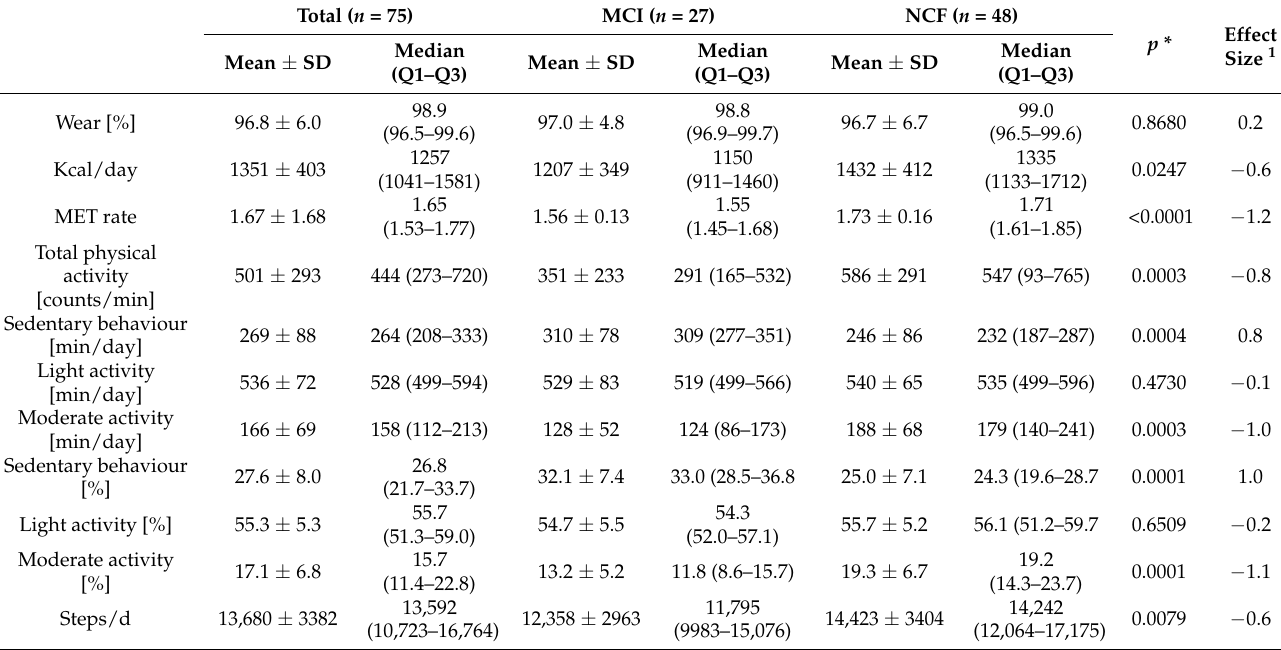
Table 4. Physical activity results assessed by the ActiGraph in the study